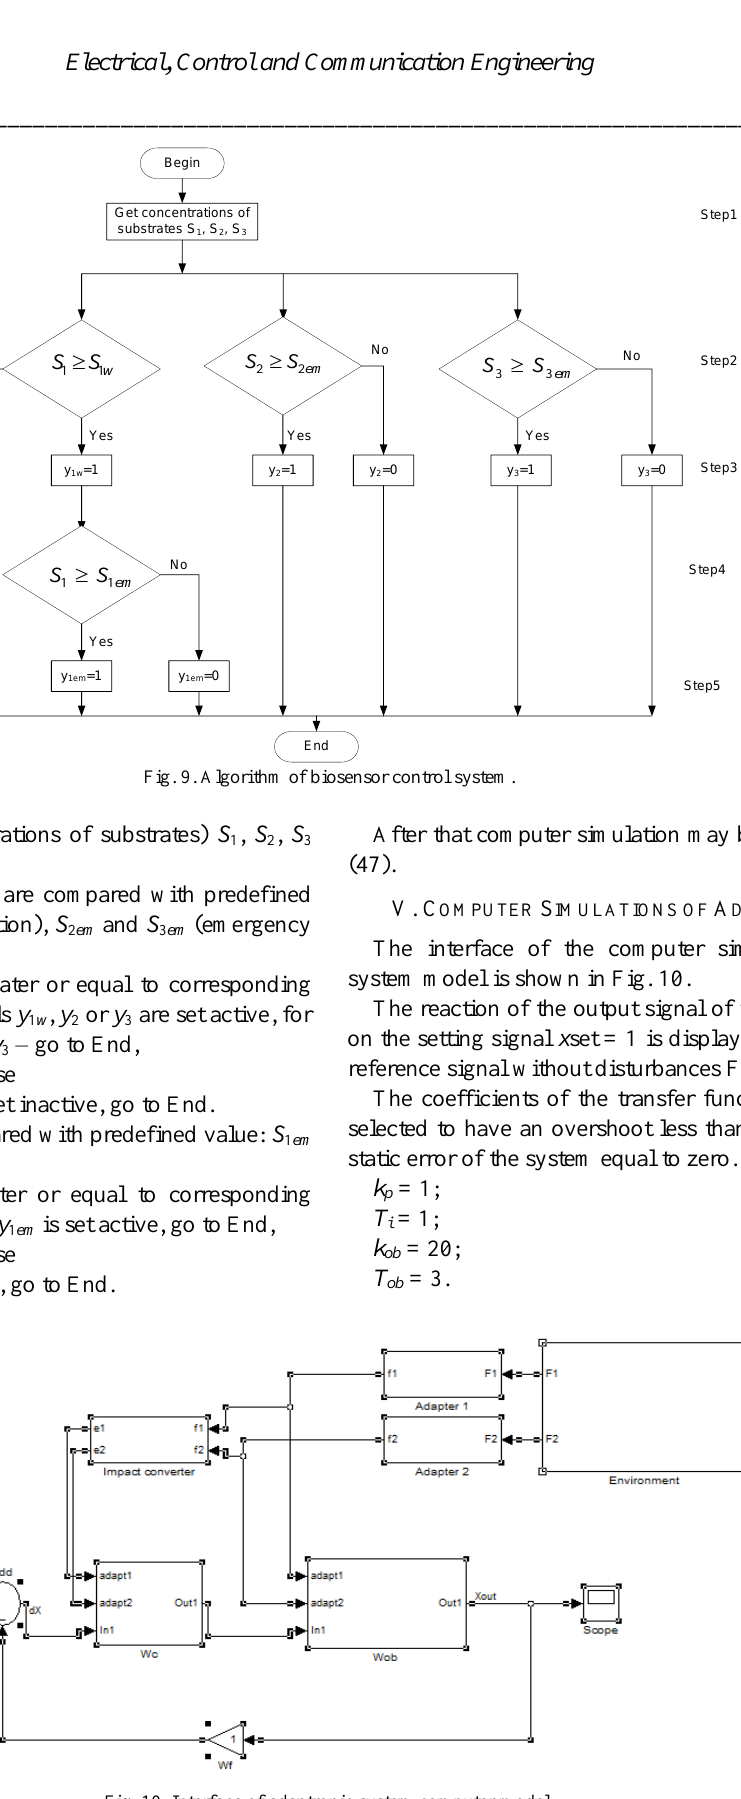
Fig. 10. Interface of adaptronic system computer